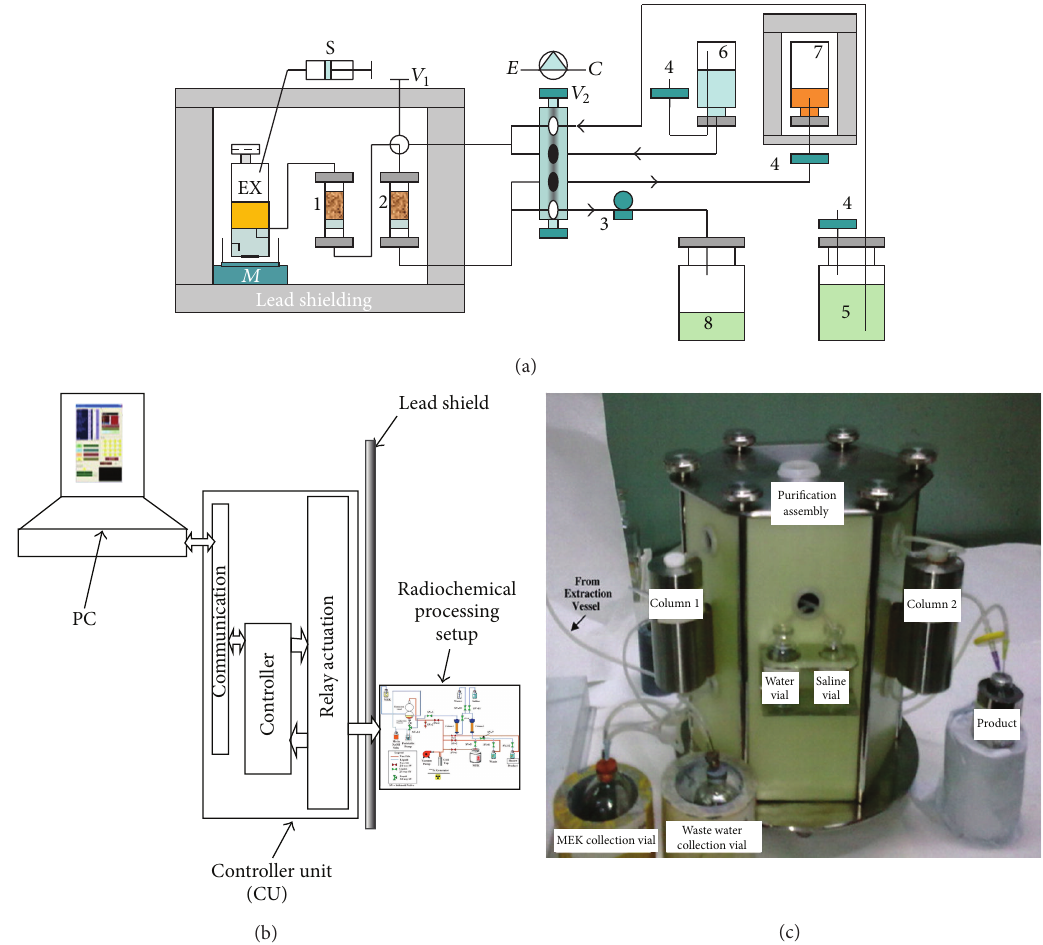
Figure 5: MEK extraction of 99 m Tc using a tandem sorbent column system for nonevaporation removing of MEK from the extracted 99 m Tc- MEK phase: (a) conceptual process diagram of 99 m Tc recovery by MEK extraction using a tandem cation-exchange resin/acidic alumina column system for nonevaporation removing of MEK (1: cation-exchange resin column; 2: alumina column; 3: peristaltic pump; 4: